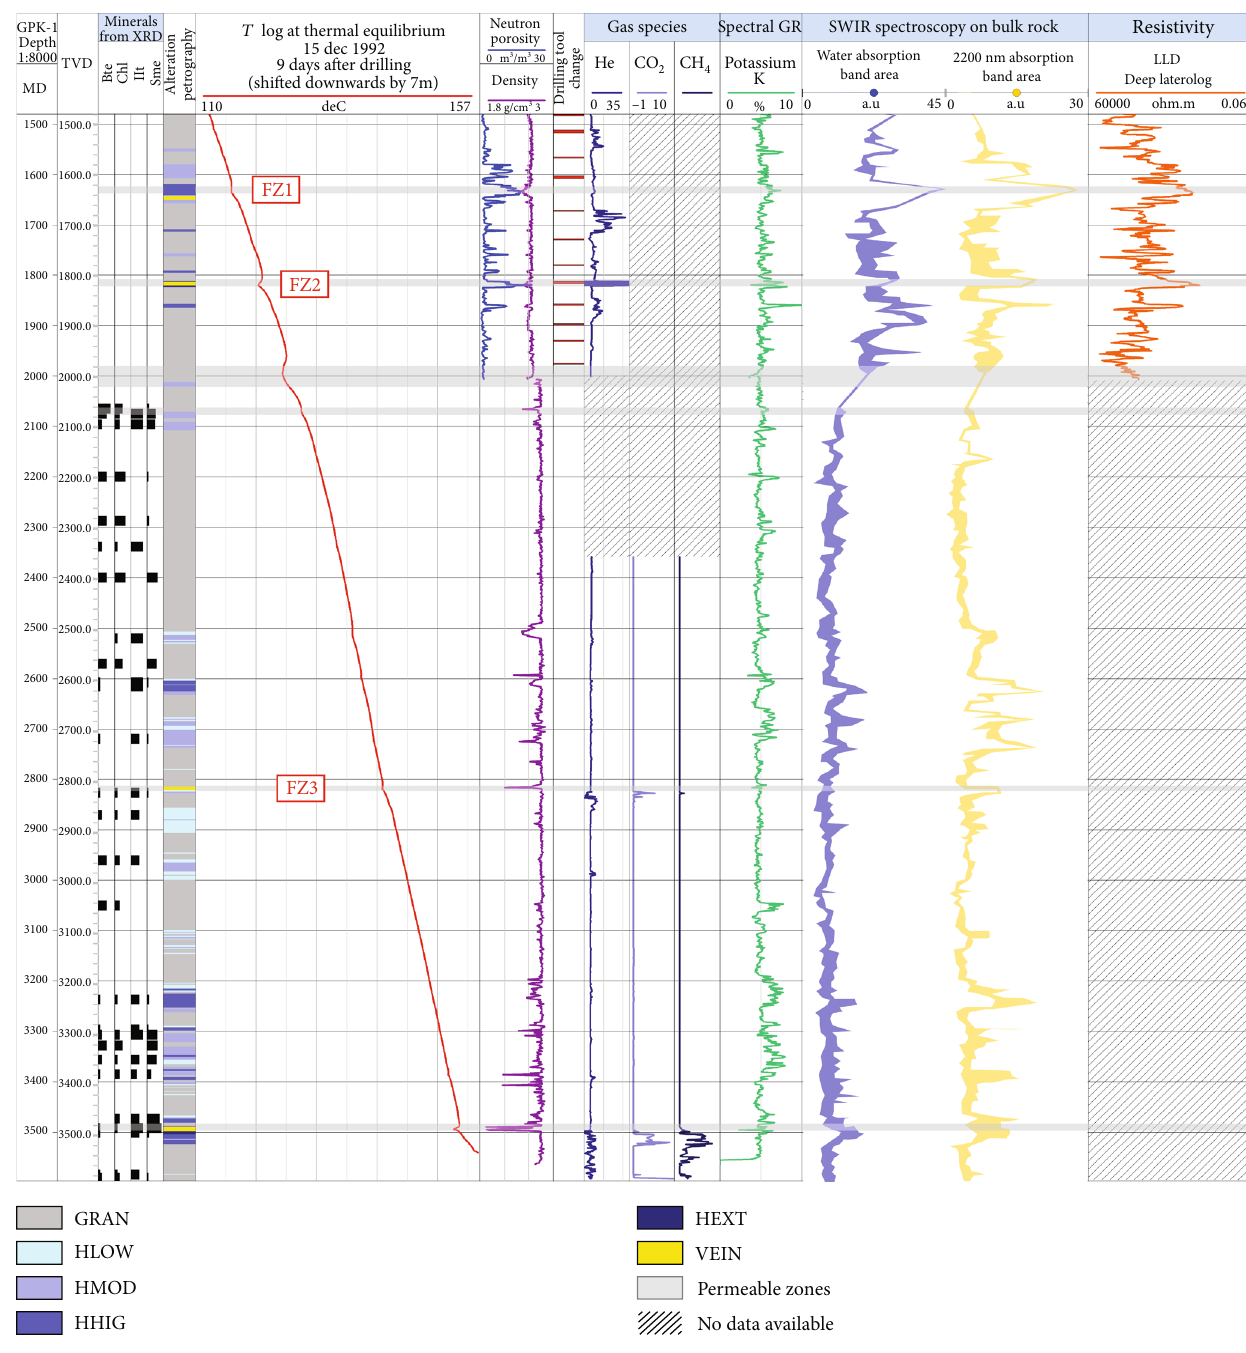
Figure 7: Composite log of the GPK-1 well at Soultz-sous-Forêts, presenting the mineral quantity, petrographical log, T log, porosity and density logs, drilling tool change, gas species, spectral GR-K, SWIR results with water and 2200nm absorption band areas, and resistivity log. Petrographical facies abbreviations are de fi ned in the legend in Figure